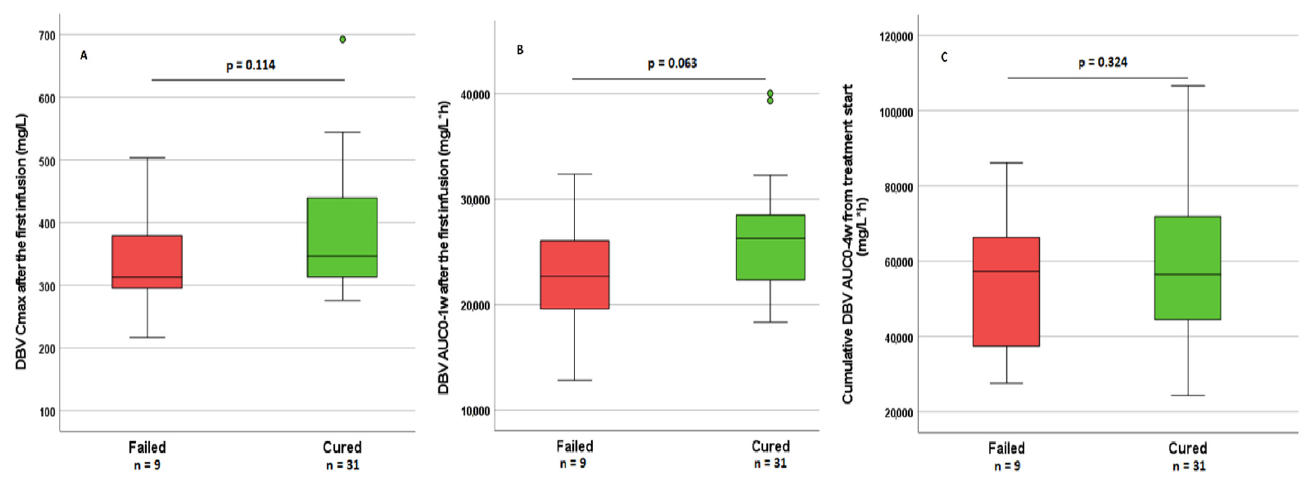
Figure 2. ( A – C ) distribution of DBV C max after the first infusion, AUC 0–1w , cumulative AUC 0–4w , and DBV levels with regard to outcomes. Among all the PK parameters which were tested for their associations with treatment outcome, C max at the first dose, AUC 0–1w , and cumulative AUC 0–4w all resulted in higher values in cured patients, although these differences were not statistically significant.